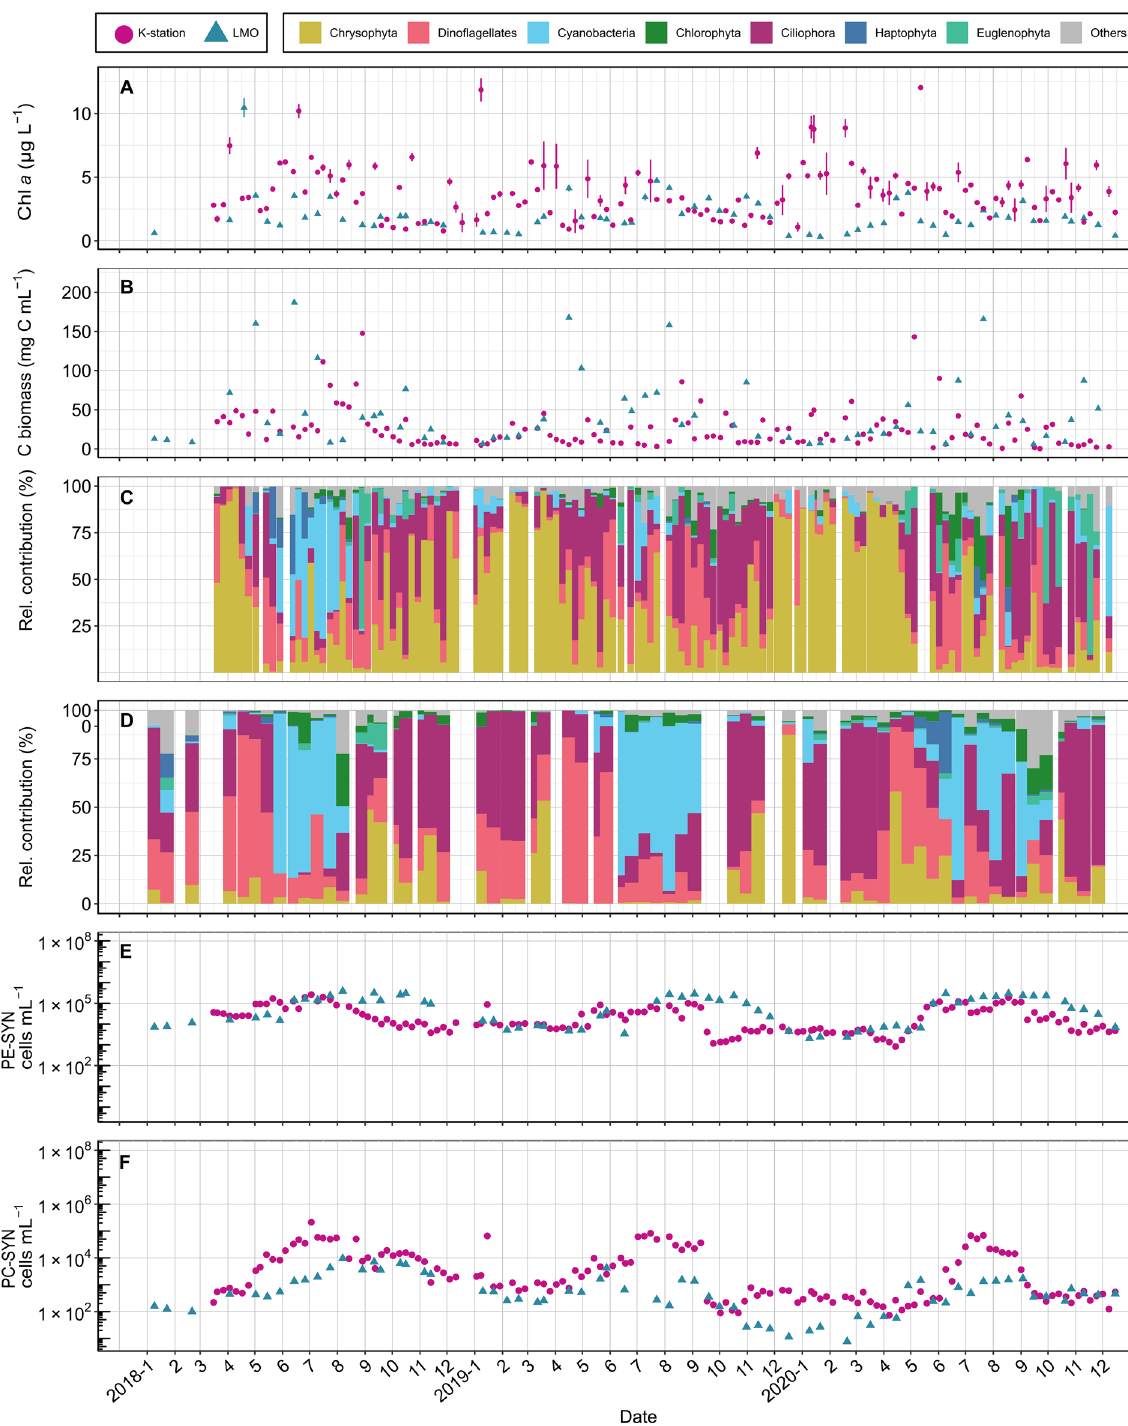
Figure 2. K-station and LMO measurements for ( a ) Chl a (µg L −1 ), ( b ) total phytoplankton (> 5 µm in diameter) carbon biomass concentration (mg C mL −1 ) based on microscopy, ( c ) K-station and ( d ) LMO relative contribution of phytoplankton divisions (> 5 µm in diameter) based on microscopy, ( e ) PE-SYN (cells mL −1 ) and ( f ) PC-SYN (cells mL −1